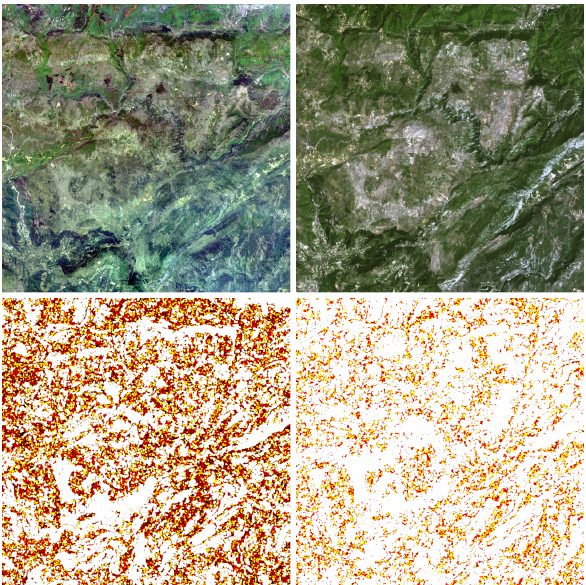
Figure 16. Top left: Crop of our orthophotomosaic. Top right: A corresponding satellite image. Bottom: Their respective maps of invariant